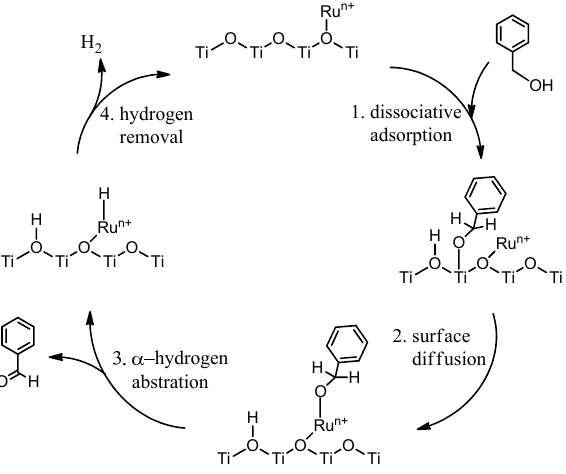
Figure 5. The proposed mechanism for the dehydration of benzyl alcohol by Ru x TiO 2 .